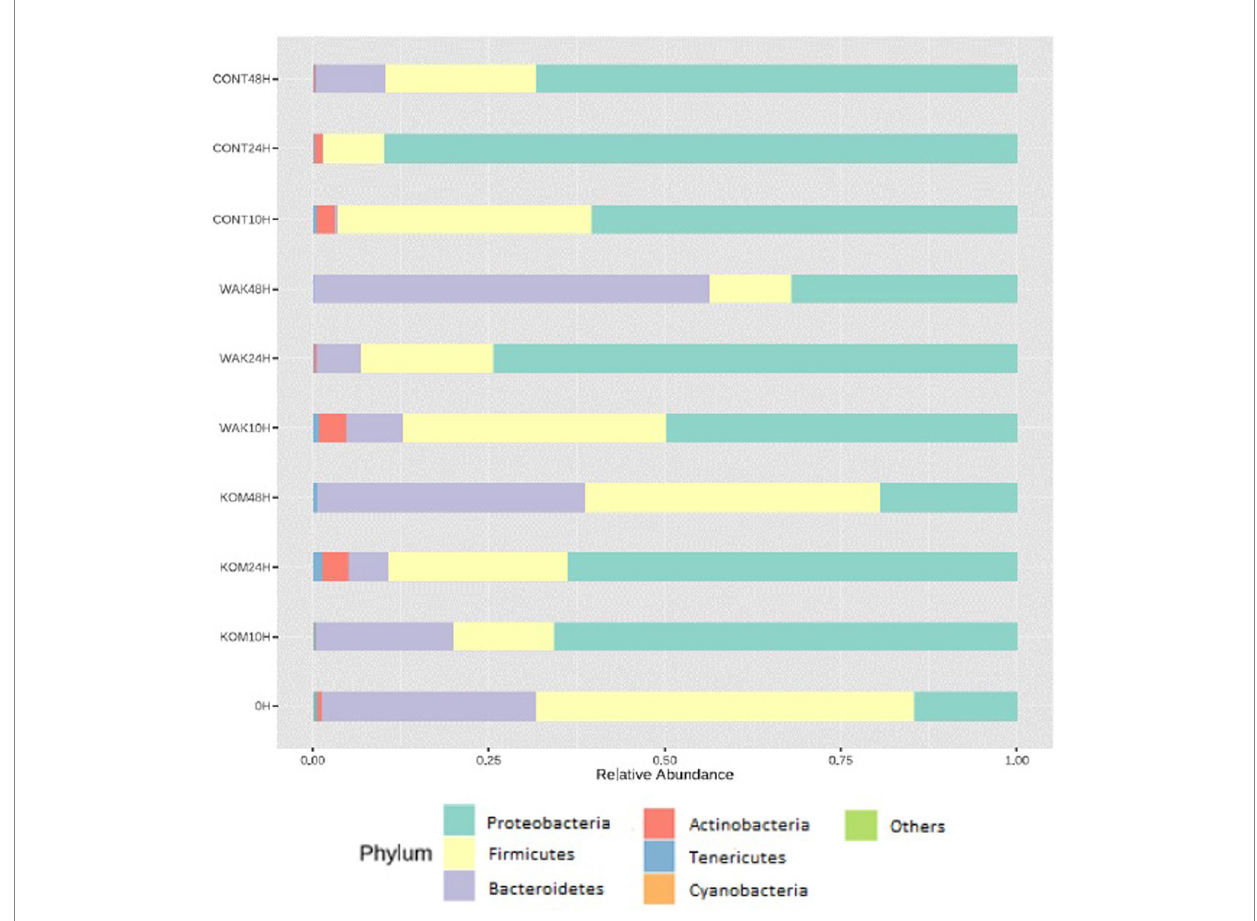
FIGURE 1 Relative abundance of different bacterial phyla. Bacterial composition (relative abundance, %) determined using 16S rRNA amplicon sequencing at the phylum. The y axis shows the different substrates evaluated at the different assay times (10, 24, and 48 h). 0 h indicates the bacterial composition before substrate addition. CONT (negative control, without substrate); KOM ( S. japonica , kombu); WAK ( U. pinnatifida ,